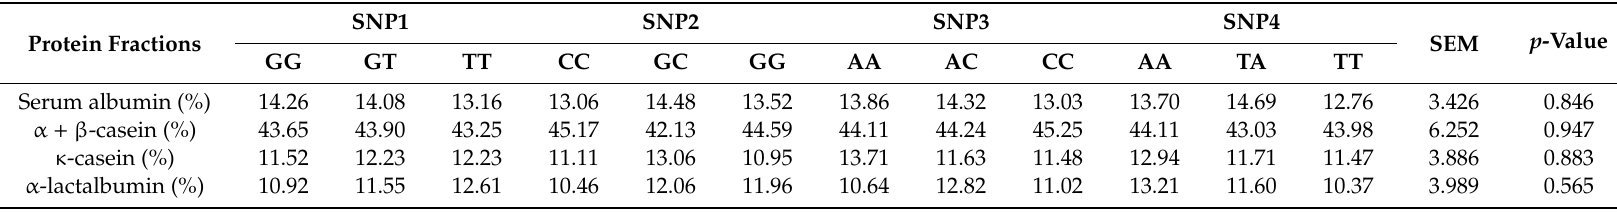
Table 4. Percentage contribution of chosen protein fractions in milk from Zošl’achten á valaška sheep in relation to particular genotypes of SLC27A3 gene polymorphisms. Protein